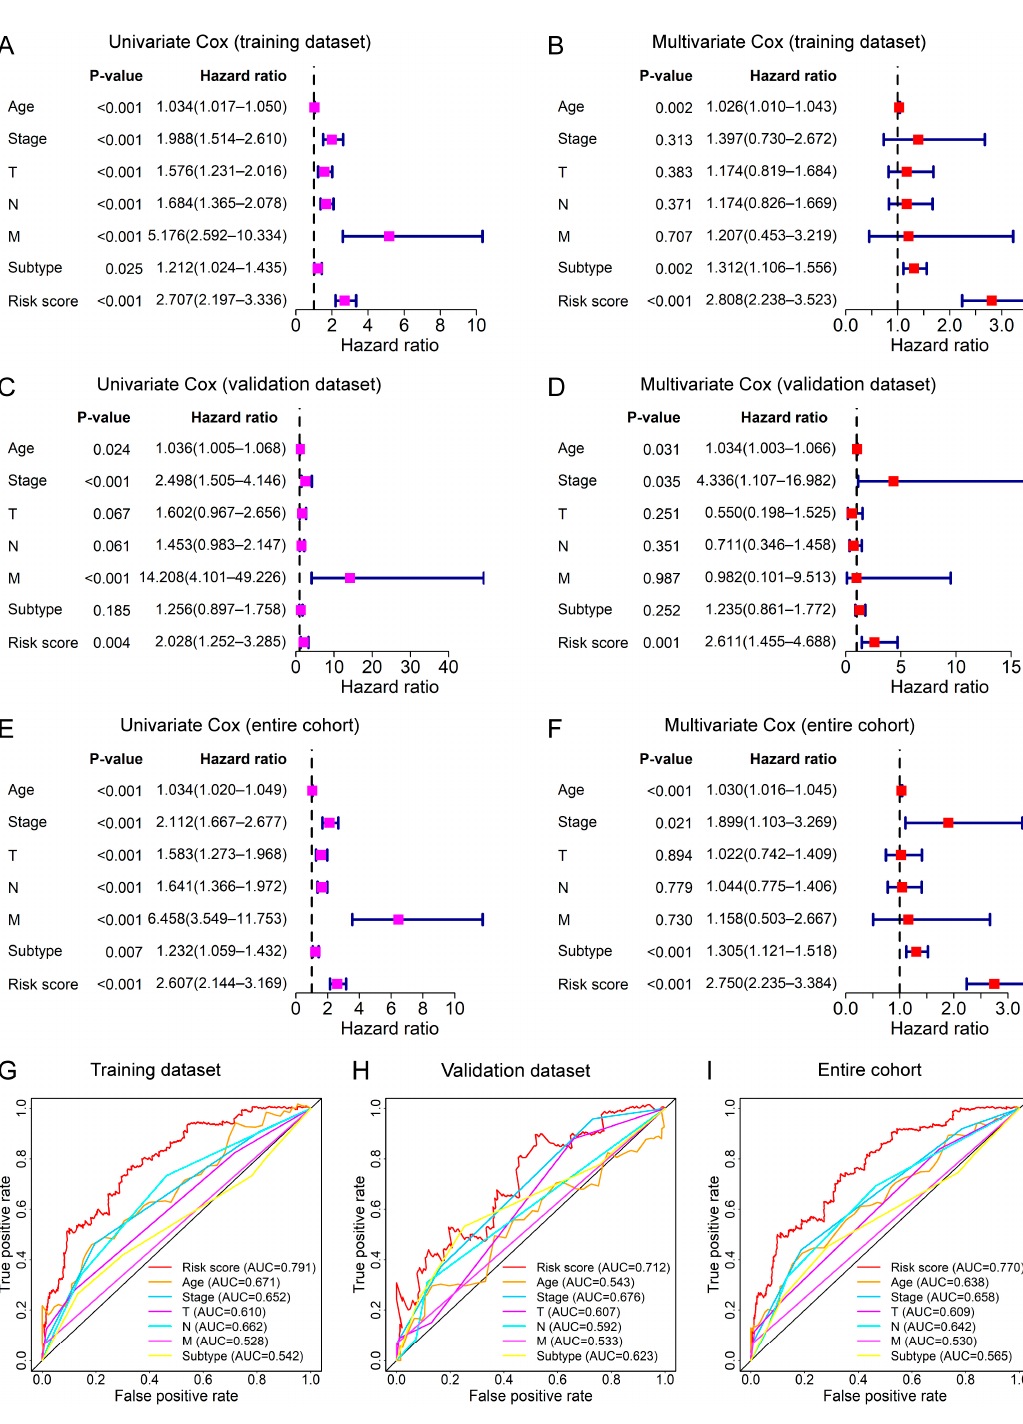
Figure 4. Assessment of the lncRNA signature as an independent prognostic factor for OS. Forest plots of the univariate ( left ) and multivariate ( right ) Cox regression analyses of risk score and several clinical features based on the OS in the training dataset ( A , B ), validation dataset ( C , D ), and entire cohort ( E , F ). The ROC curves at 5-year OS of the risk score and clinical features in the training dataset ( G ), validation dataset ( H ), and entire cohort ( I